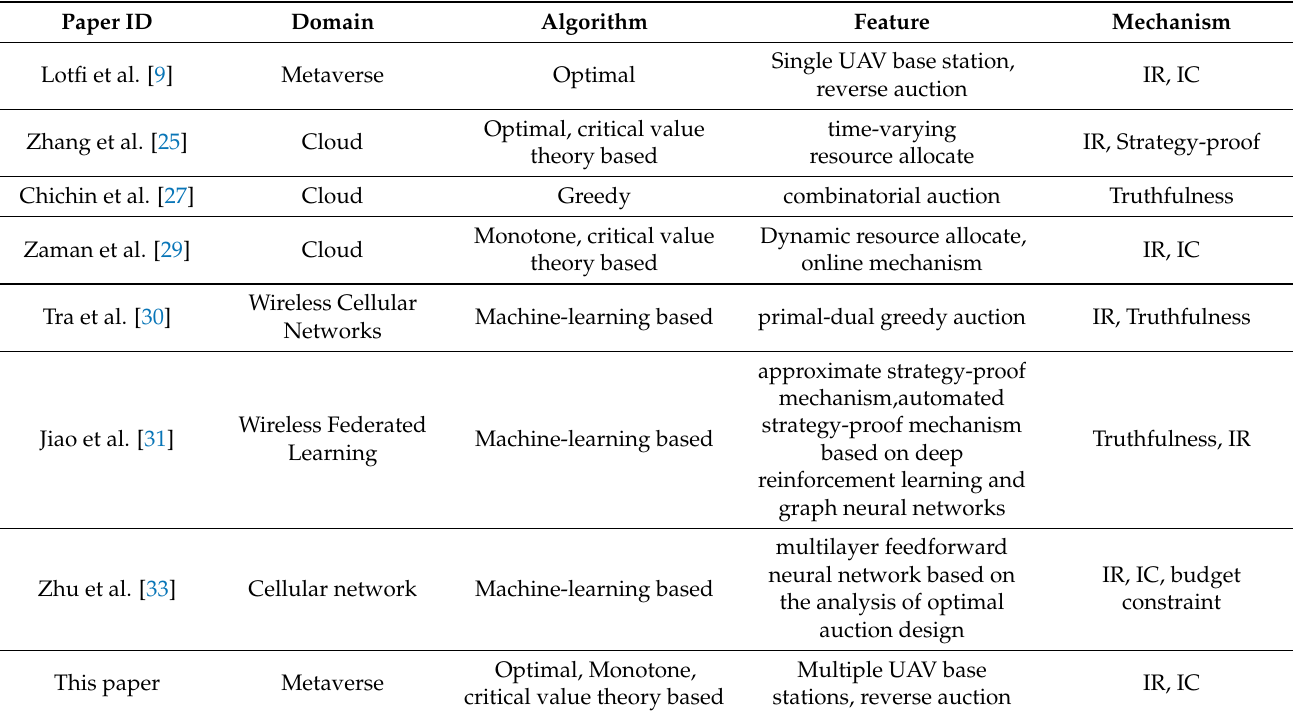
Table 1. Comparison of this paper with the related